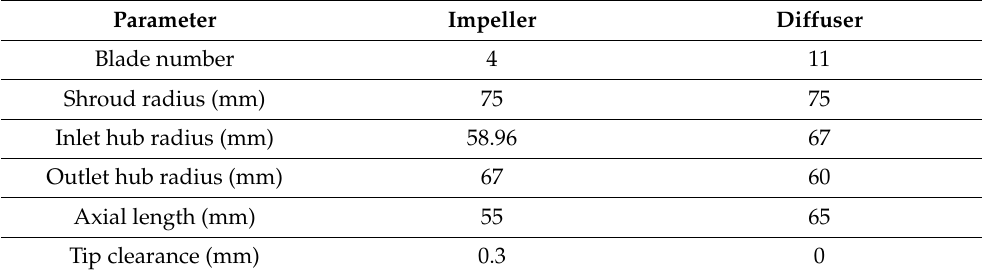
Figure 2. Computational model of an axial-flow multiphase pump. Table 1. Structural parameters. Table 1. Structural parameters.